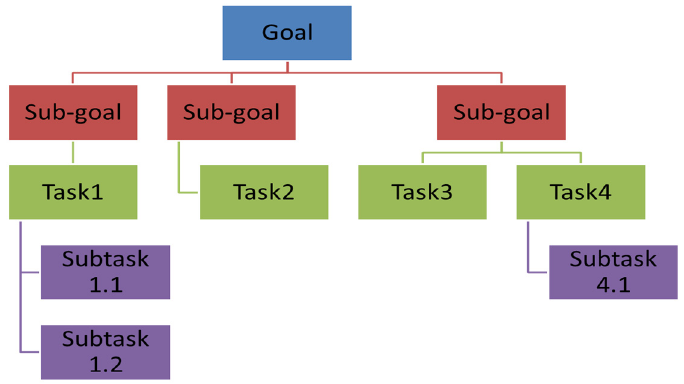
Figure 4. Example of Hierarchical Task Analysis (HTA) workflow.